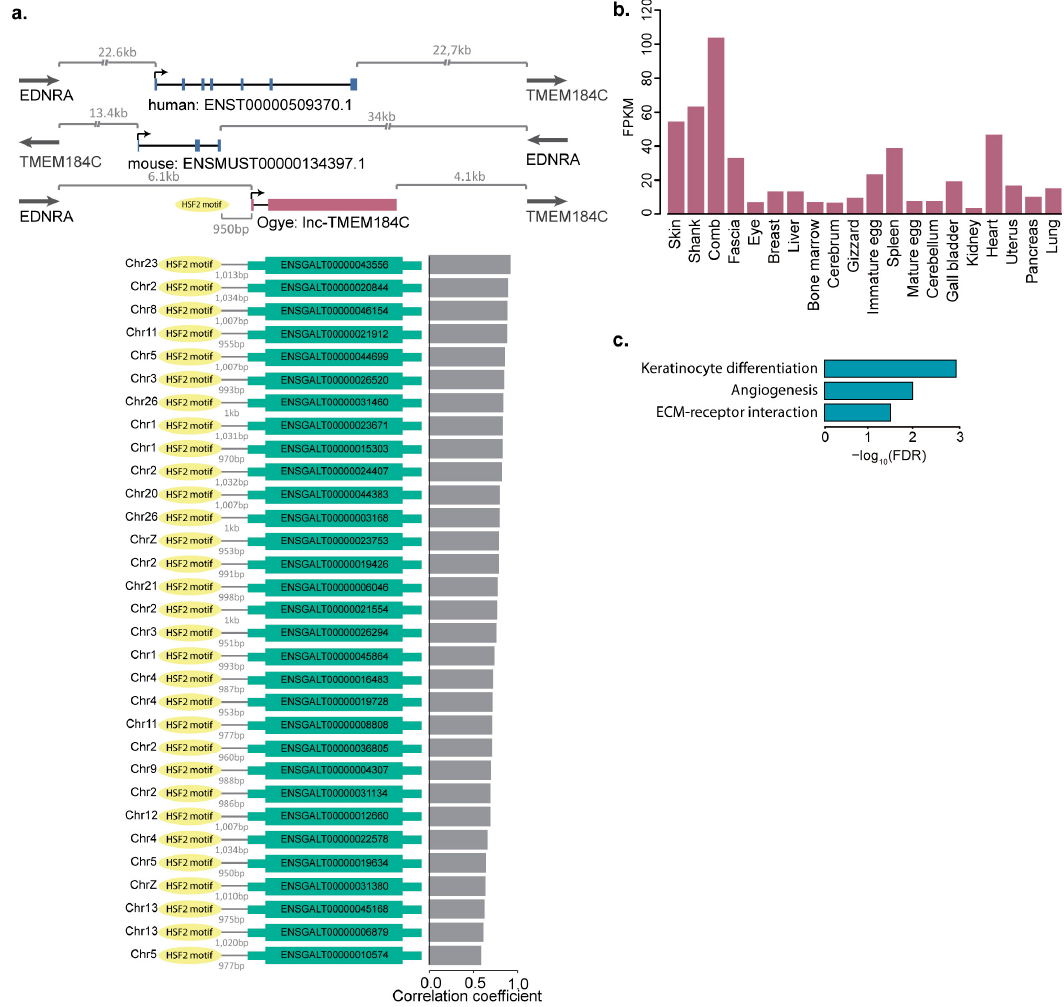
Figure 7. Example of black skin-specific lncRNAs with synteny conservation, which is transcriptionally regulated by HSF2. ( a ) Ogye lncRNA ( lnc-TMEM184C ) with synteny conservation in human and mouse genomes (top). The lncRNA has an HSF2 binding motif in its promoter; this motif is also present in the promoters of protein-coding genes with correlated expression (below). Gray bar plots indicate the expression correlation between the lncRNA and protein-coding genes. ( b ) Lnc-TMEM184C expression pattern across 20 tissues. ( c ) GO terms significantly associated with the protein-coding genes co-expressed with lnc-TMEM184C .